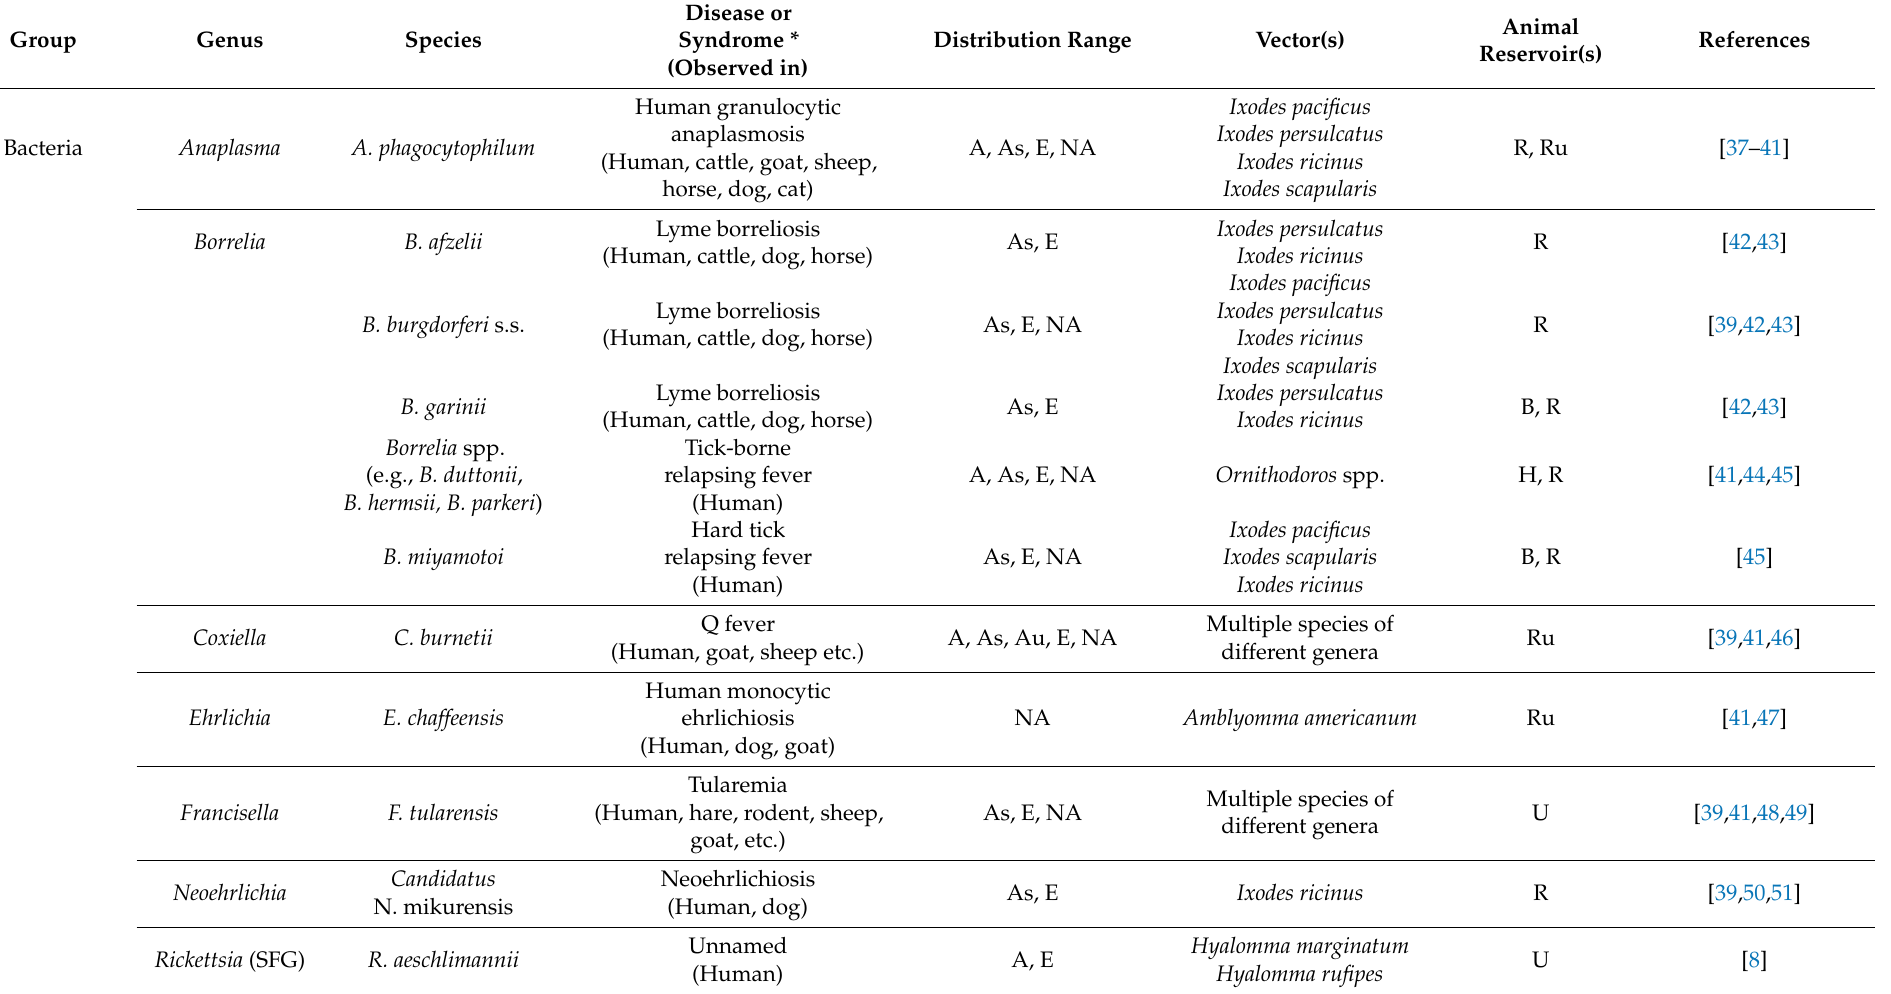
Table 1. Causative agents, distribution range, vectors, and animal reservoirs of selected tick-borne